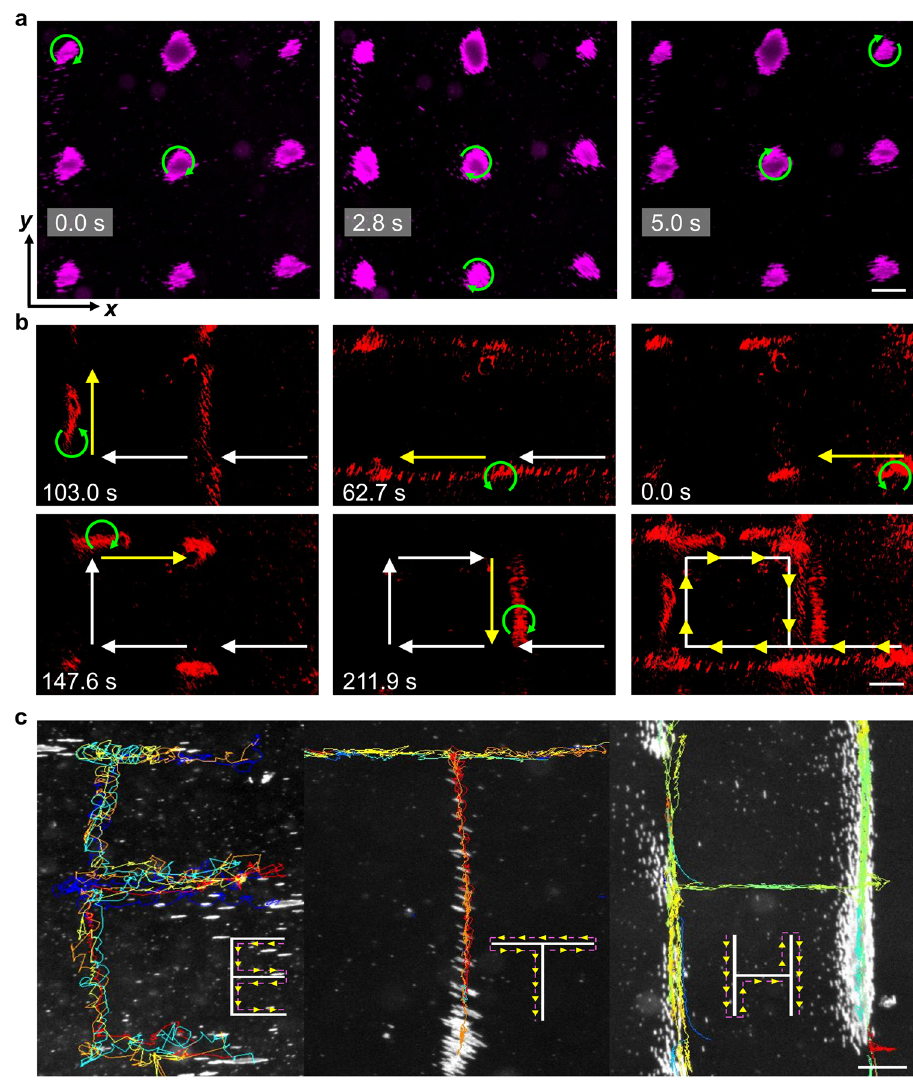
Fig. 5 | Two-dimensional dynamic rolling manipulation. a In situ rotation of microchains at two-dimensional acoustic pressure nodal points. b Rolling of microchainsalongapredesignedsquarepath.Thelastsub fi gureisasuperimposed time-lapse image showing the fullpath.The green curvedarrow, yellowarrow,and white arrow respectively denote the rotational direction, rolling direction, and